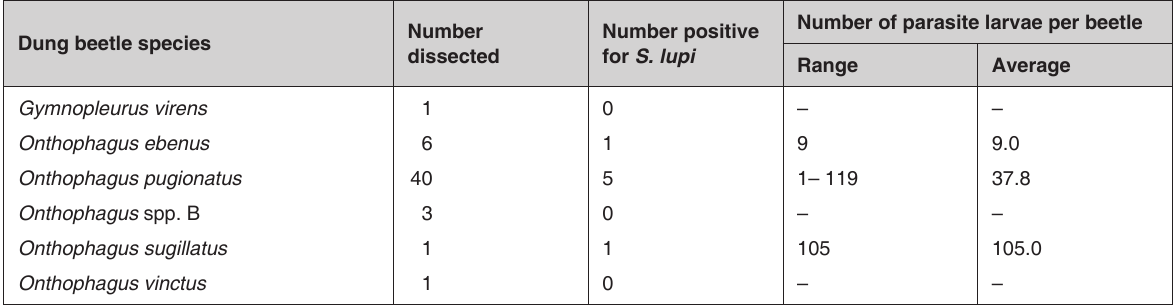
TABLE 1 Results of the dissection of various dung beetle species from an urban area in the Tshwane (Pretoria) Metropole to inves- tigate the incidence of infection with Spirocerca lupi under natural conditions Number Dung beetle species